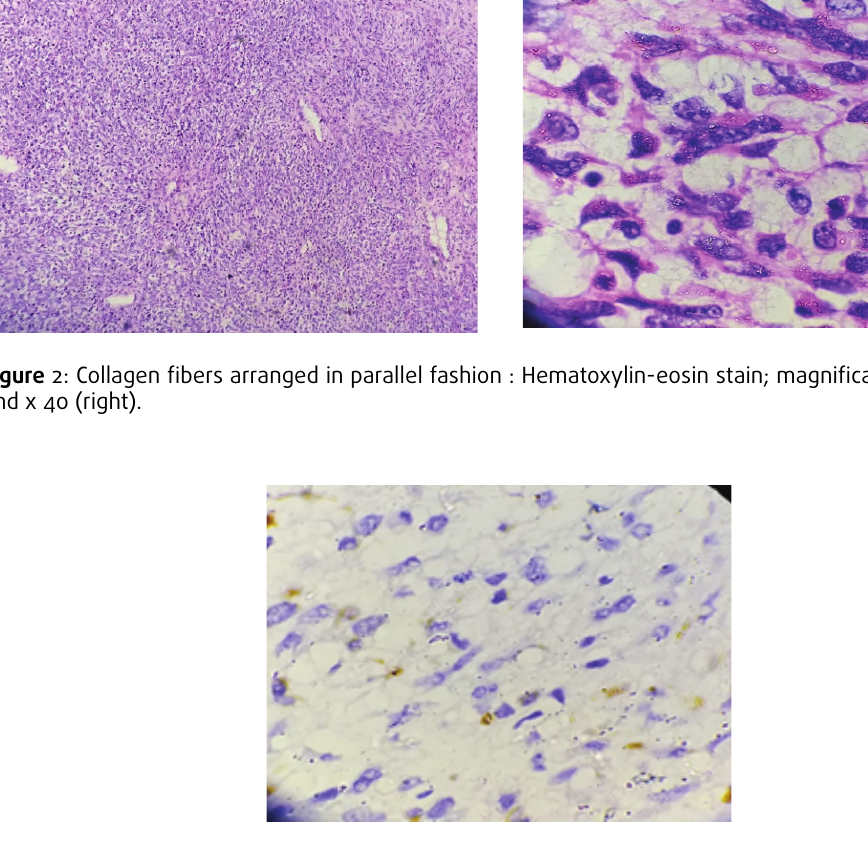
Figure 3: Ki67 immunochemistry is positive—in about 10% of tumor cells (magnification x 40).